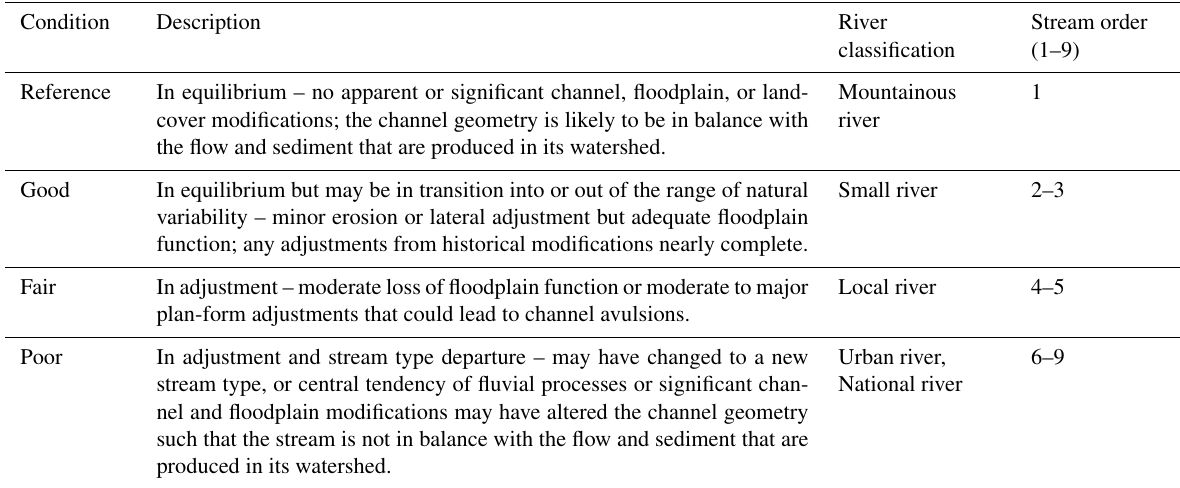
Figure 4. Stream geomorphic conditions: (a) stream order and (b) stream geomorphic conditions. Table 3. Description of the stream geomorphic conditions (Kline et al., 2009) and stream order for the watershed-health assessment of the geomorphic condition in the Han River